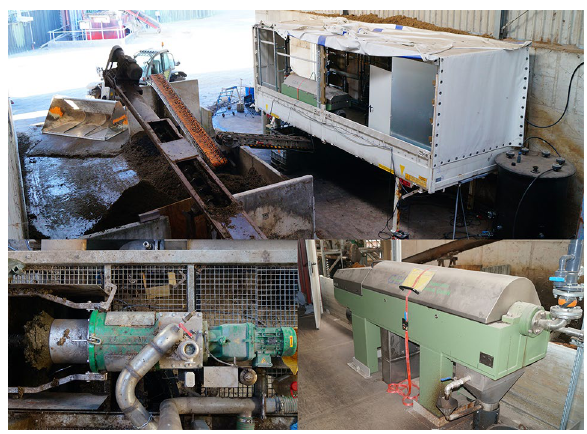
Fig. 2 Installed separation equipment, top: container with decanter centrifuge; left: screw press separator; right: decanter